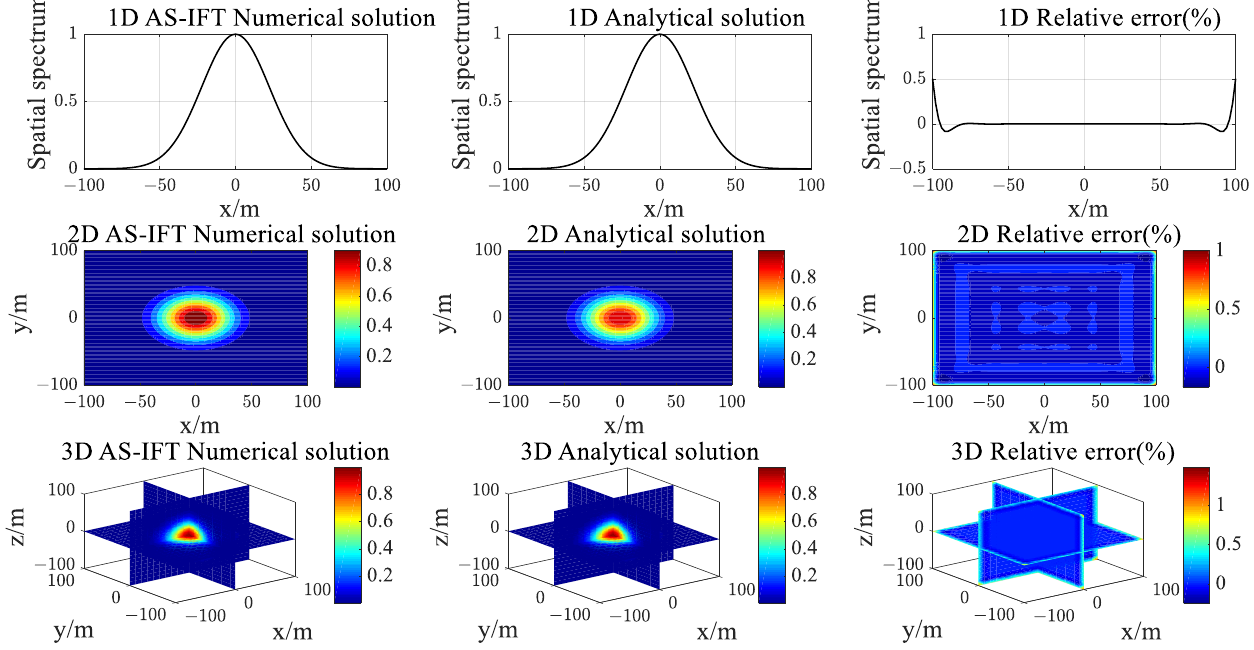
Figure 3. The numerical solution, analytical solution, and relative error of the inverse transform.